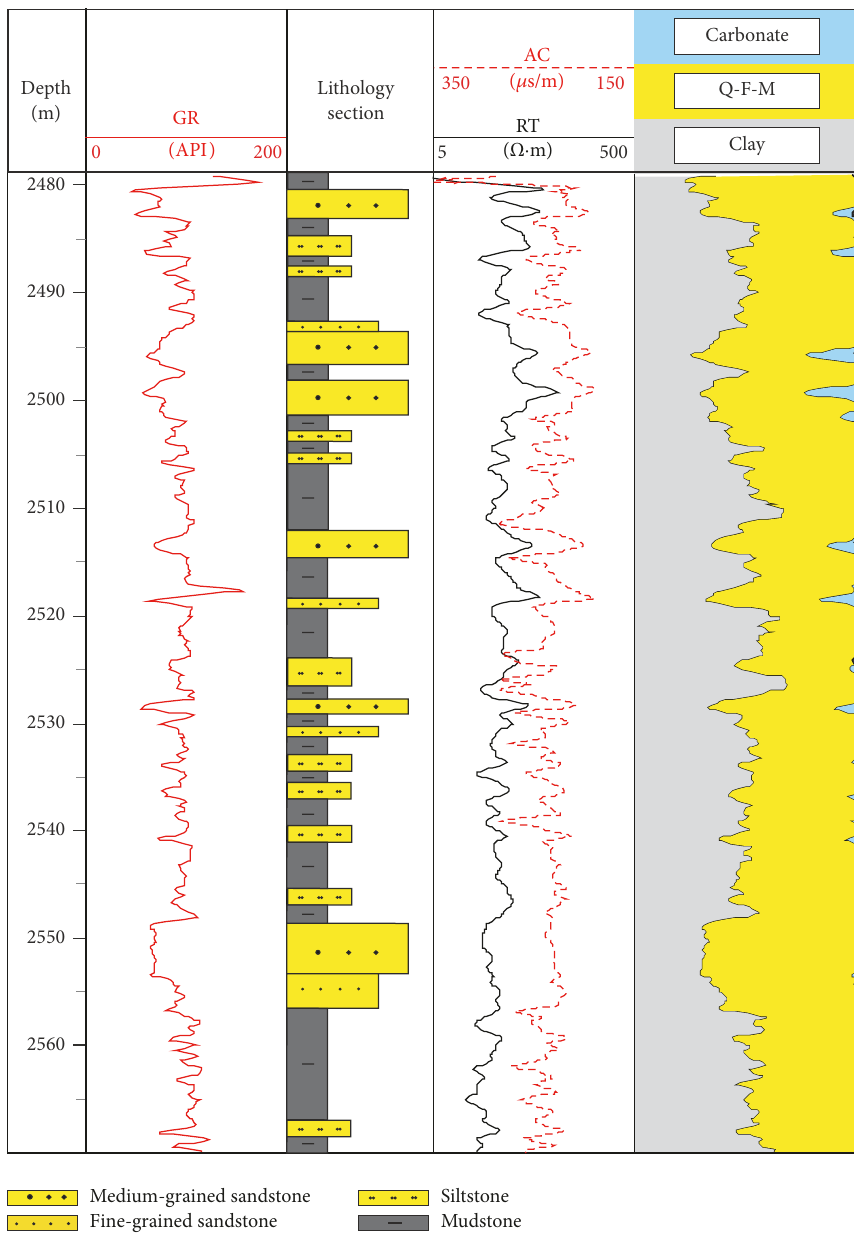
Figure 11: Diagenetic mineral assemblage characteristics interpreted by ECS logging in Well